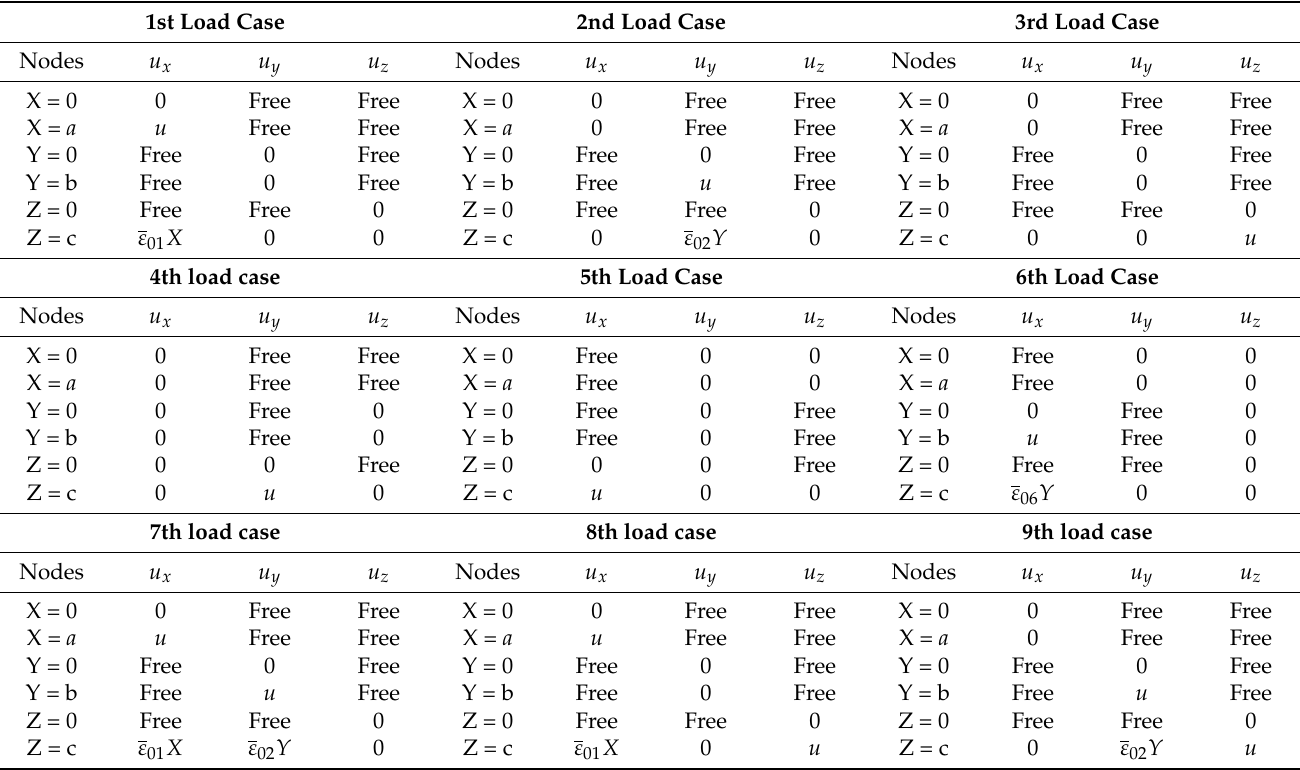
Table 1. Displacement boundary conditions for the nine load